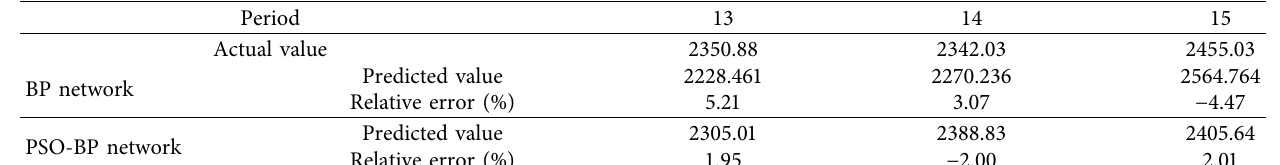
Table 7: ZL2-7 actual value and predicted value comparison results table.